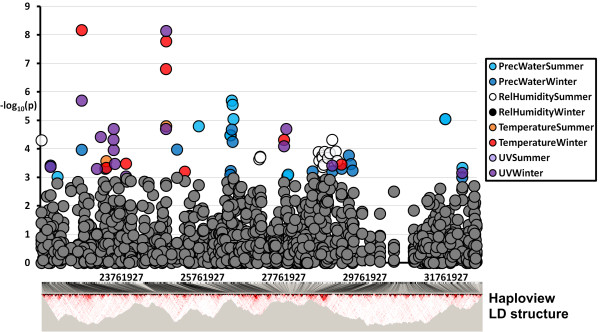
Typical MAGICS output for a 25 Mb region on chromosome 1. A typical MAGICS output is exemplified by a randomly selected region of chromosome 1 in which all genic windows are represented by their –log10P values. Windows yielding a –log10P > =3 are colored according to the climate variable associated with the p value. The bottom part of the plot reports the average worldwide linkage disequilibrium structure for the same region, obtained by Haploview software [29] on all the samples in the study. The LD structure is provided for the sample region to indicate the independence of MAGICS hits.